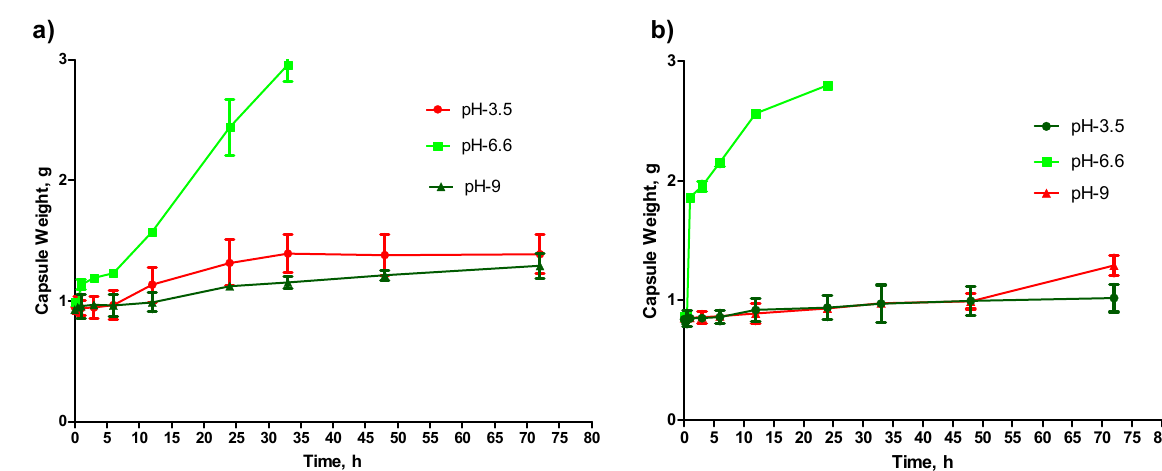
Figure 5. Analysis of capsules’ behavior in different media (pH 3.5, 6.6, and 9). ( a ) Weight of alginate capsule recorded at a different interval. ( b ) Weight of MMT enhanced alginate capsule recorded at a different interval ( n = 3, ±SD).